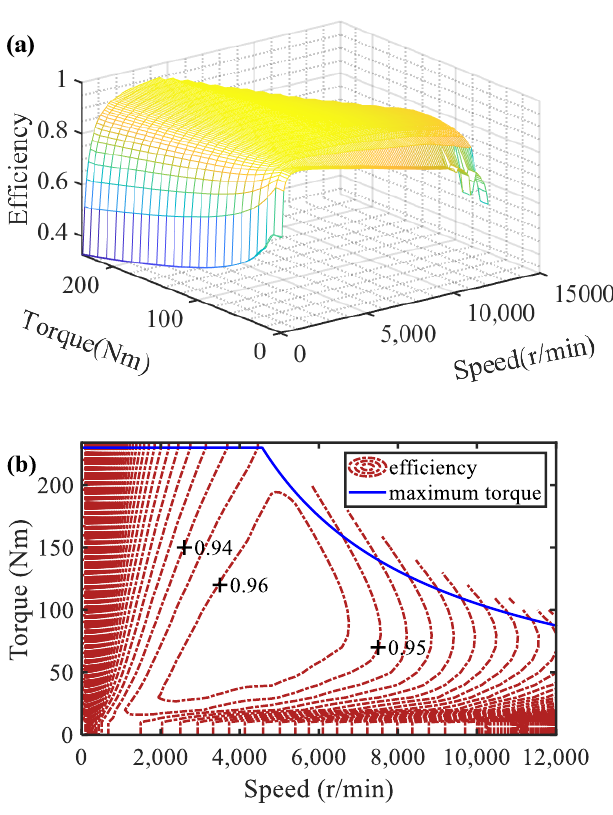
Figure 4. Motor efficiency map: ( a ) 3-D efficiency map; ( b ) Contour efficiency map.